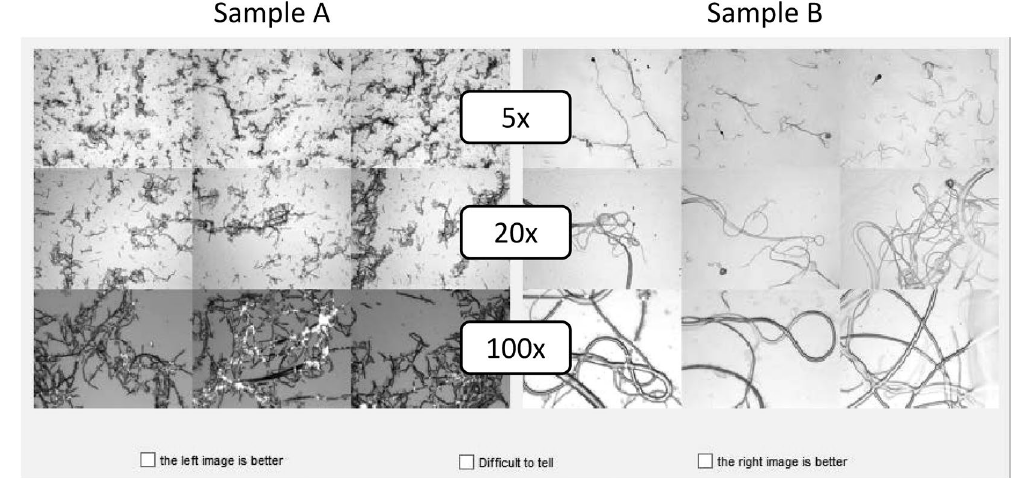
Figure 3. Fiber quality comparison example. The montage of fiber images from two experimental settings are compared visually. For each experiment there are three images for each of three different magnifications: 5x (top row), 20x (centre row) and 100x (bottom row). In this example, the “A” sample on the left is preferred because it is more homogeneous, even though some debris is present. The “B” sample is cleaner, but is not homogeneous, and contains some fibers that are too